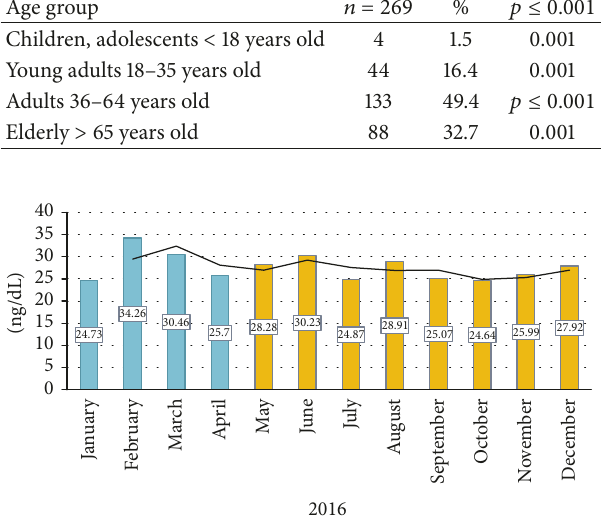
Figure2:25(OH)-Dlevelsduringthe12monthsoftheyear.Months with the lowest sun exposure: January–April (winter); months with the highest sun exposure: May–December (summer).